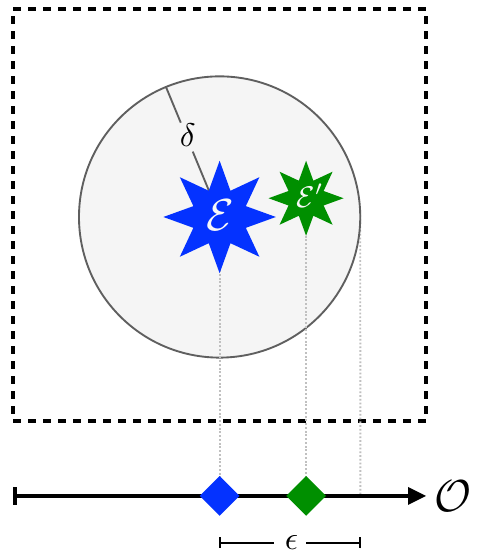
Figure 3 . An illustration of IRC safety of an observable as continuity in the space of events. As formulated in eq. (1.6), small perturbations to the event, as measured by EMD, yield small changes in the observable